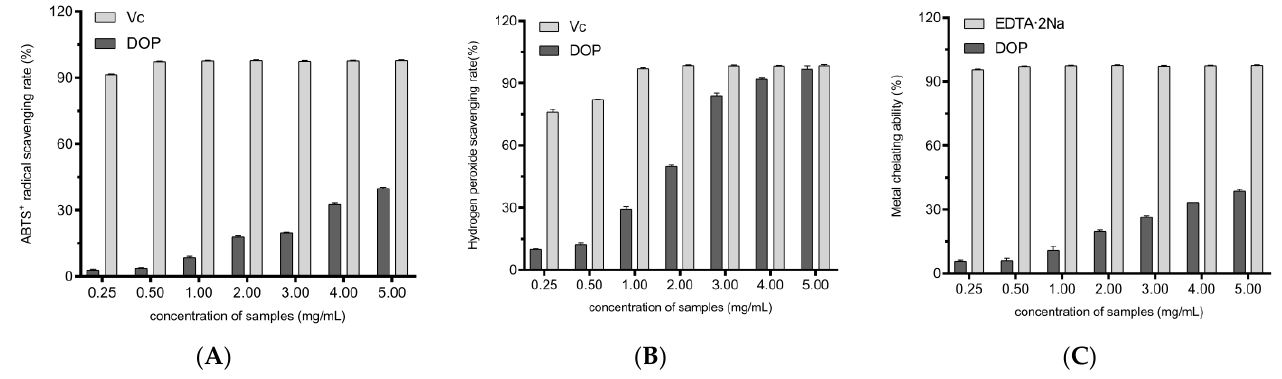
Figure 3. ABTS + scavenging ability ( A ), hydroxyl radical scavenging ability ( B ), and metal chelating ability ( C ) for different concentrations of DOPs.